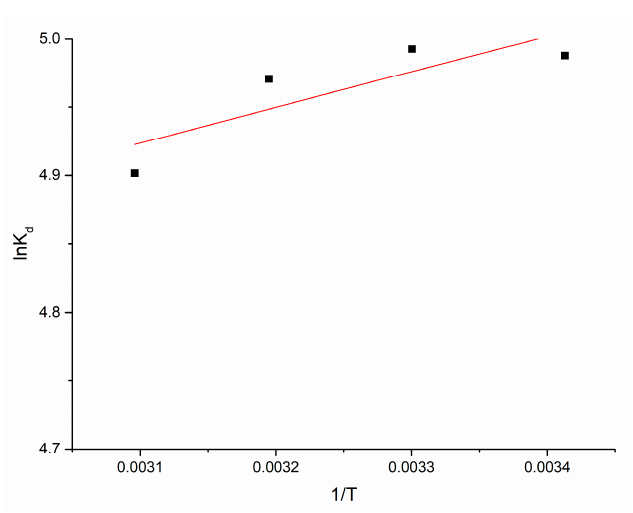
Figure A1. Graph of lnK d versus 1/T.